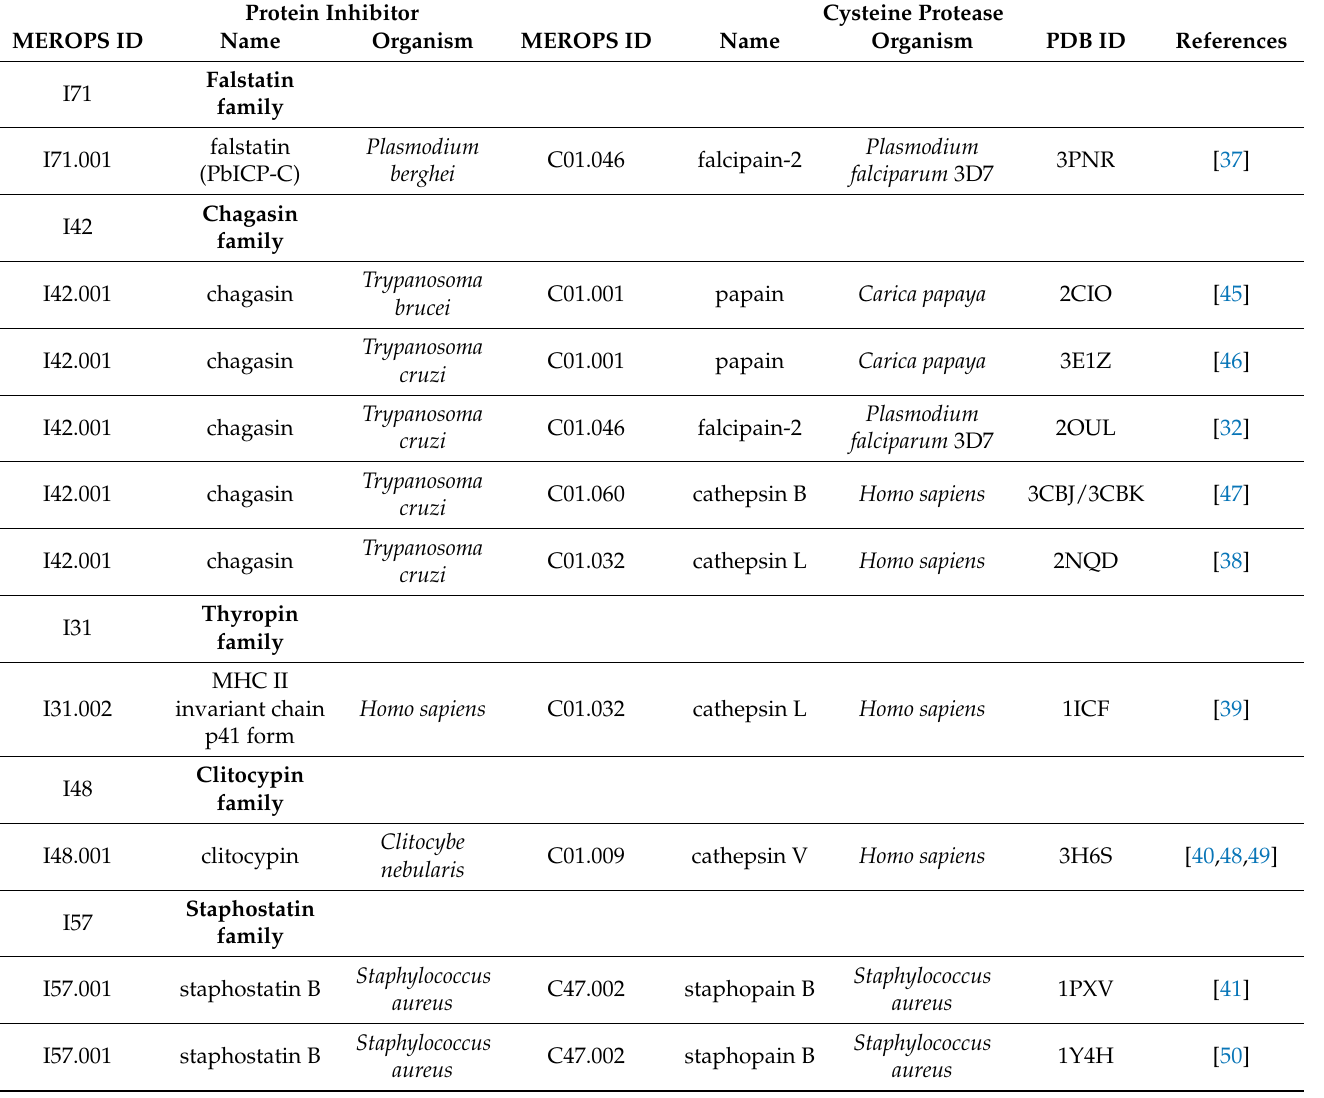
Table 2. List of the available structures of the complexes between protein inhibitors and cysteine proteases: falstatin, chagasins, thyropin, clitocypin, and